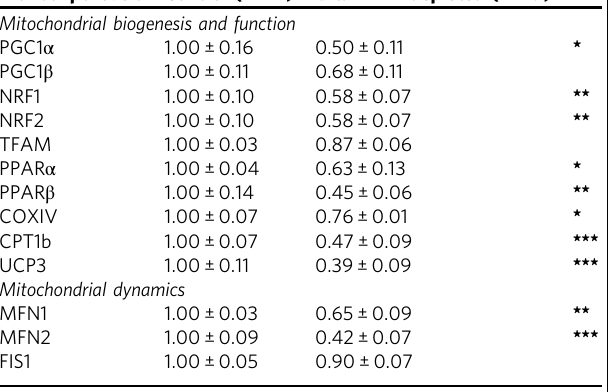
Table 1 Expression of genes involved in mitochondrial biogenesis, function, and dynamics in plantaris muscles from control ( n = 7) and vitamin D-depleted ( n = 9) rats.